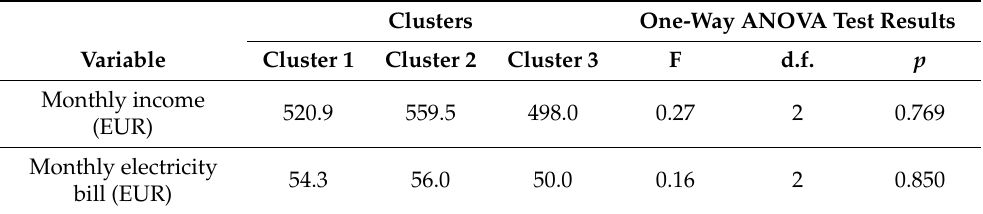
Table 13. One-way ANOVA test results of continuous socio-demographic variables between clusters in